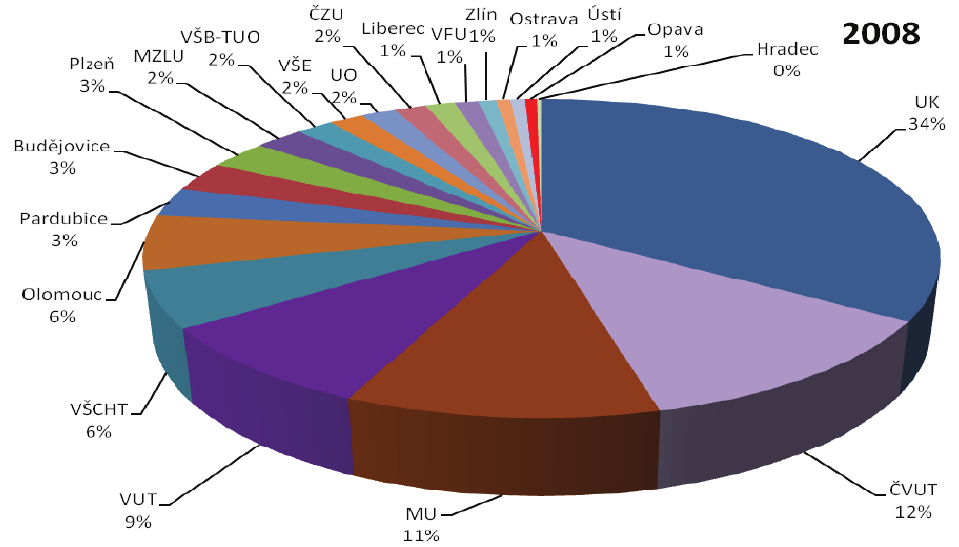
Figure 1. Relative university scores in 2008 and